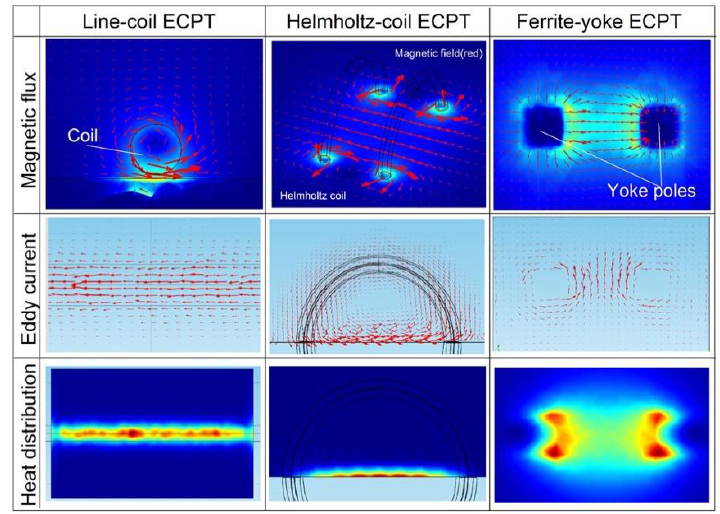
Figure 5. Simulation results of ECPT with different configurations such as line-coil-, Helmholtz-coil-, and Ferrite-yoke-based excitation on a multi-physical-phenomenon and coupling effect.